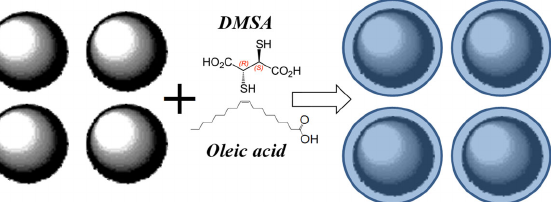
Figure 40. Scheme of the as ‐ prepared γ‐ Fe 2 O 3 or γ‐ Fe 2 O 3 /Fe 3 O 4 nanoparticles coating with DMSA or oleic acid. Adapted from Ref. [72] with permission from Elsevier: Spectrochimica Acta, Part A: